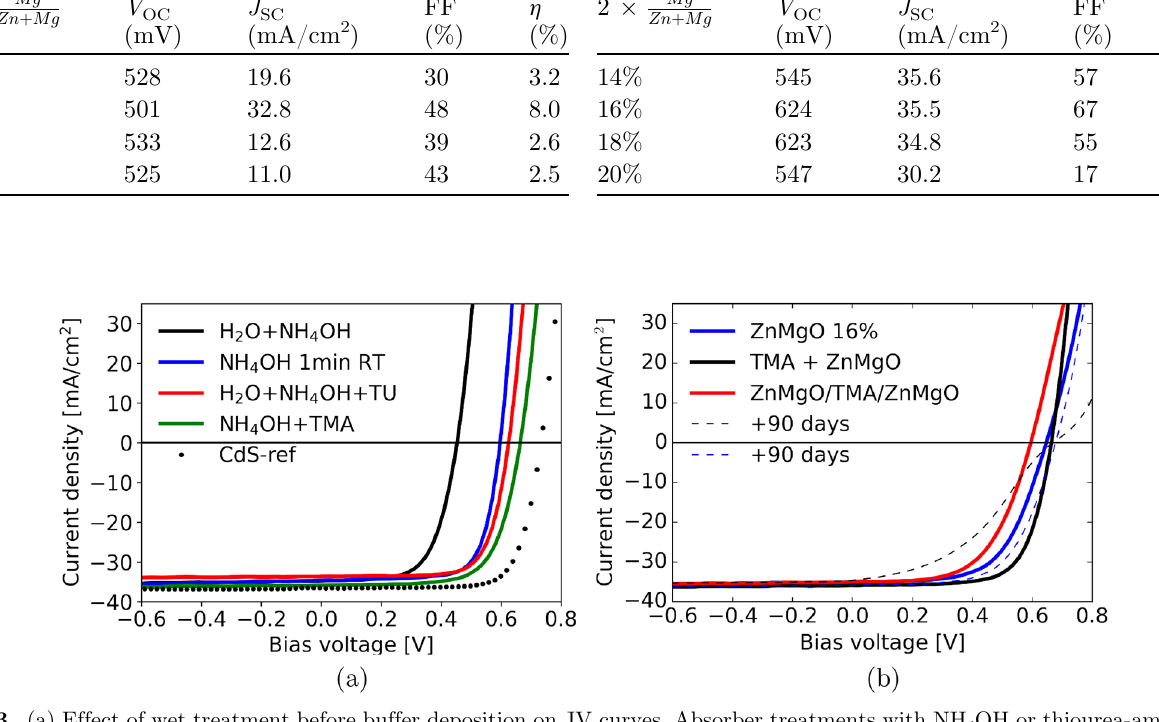
Fig. 3. (a) Effect of wet treatment before buffer deposition on JV curves. Absorber treatments with NH 4 OH or thiourea-ammonia solution show increased V OC . Additional (b) In fl uence of a single TMA pulse before and during buffer deposition, with unchanged